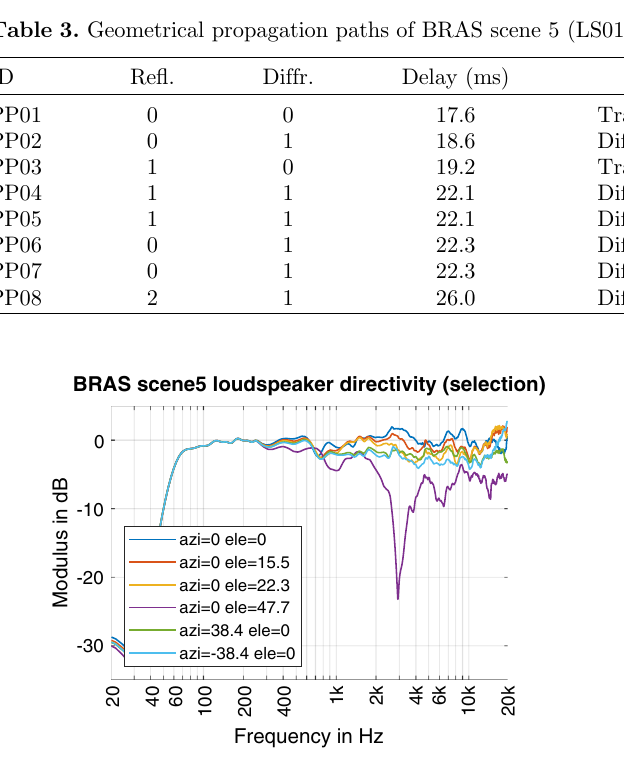
Figure 16. Measurement and simulation result of BRAS scene 5 (LS01, MP01) [46] in the time